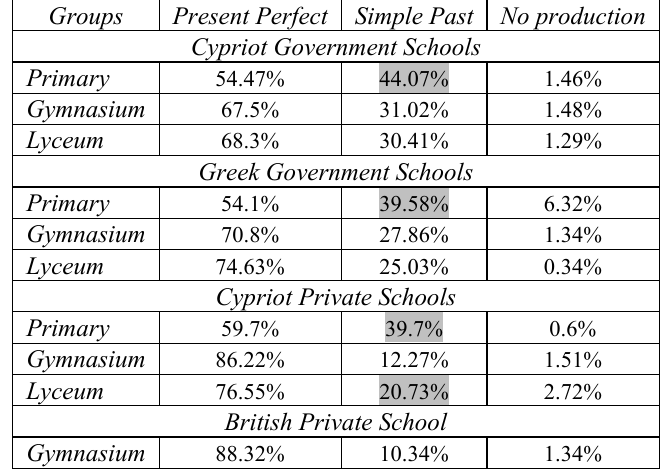
Table 6: Test production by all